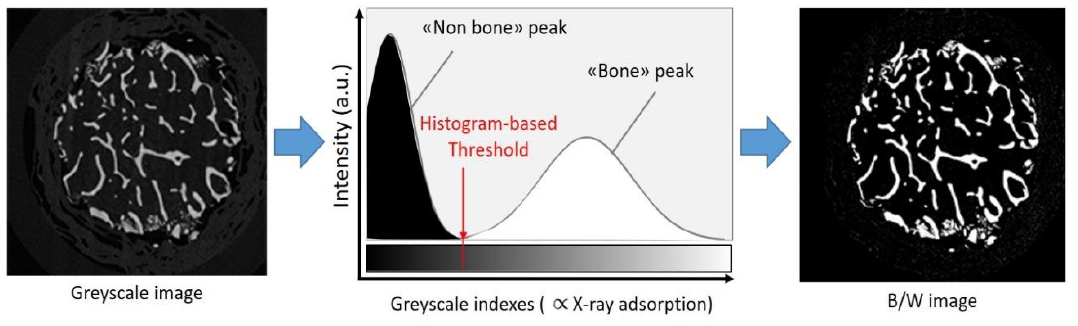
Figure 13. Histogram method for the segmentation threshold choice.